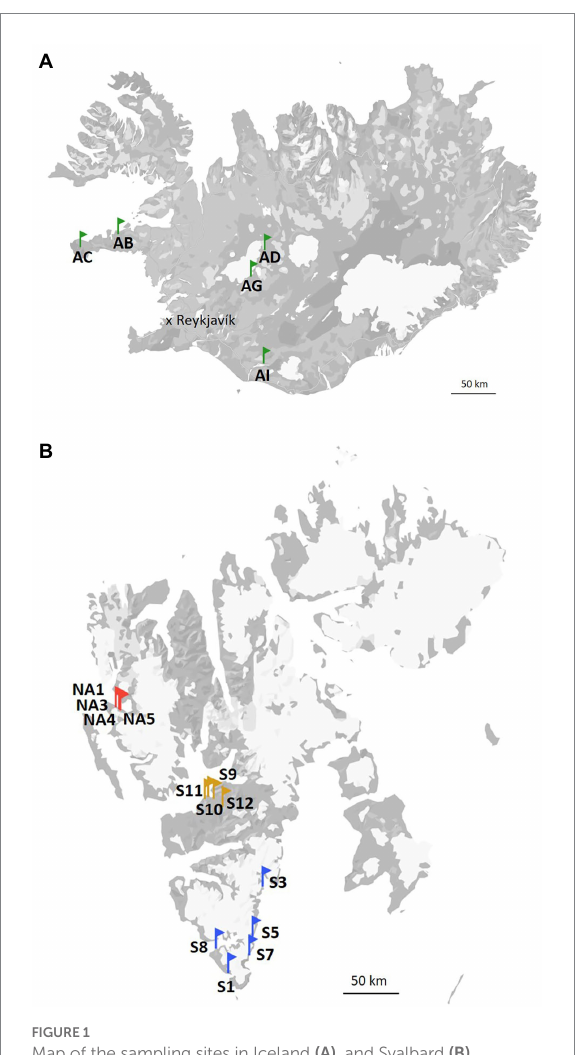
FIGURE 1 Map of the sampling sites in Iceland (A) , and Svalbard (B)